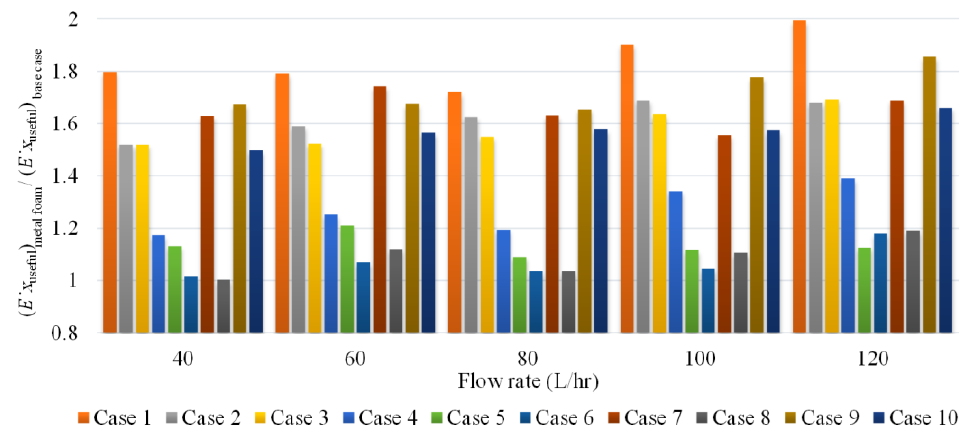
Figure 2. The ratio of the useful exergy of metal foam cases to the base case for different flow rates at the inlet temperature of 20 °C.